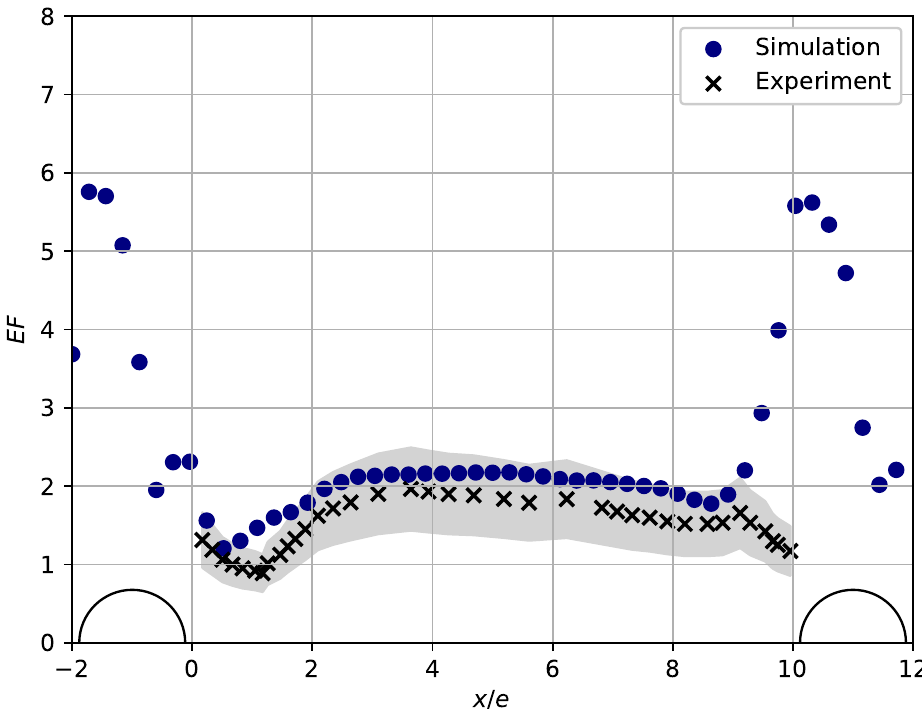
Figure 10. Comparison between measurement and simulation of the Nusselt number in relation to the smooth pipe between the ribs; the grey area shows the maximum and minimum values of the